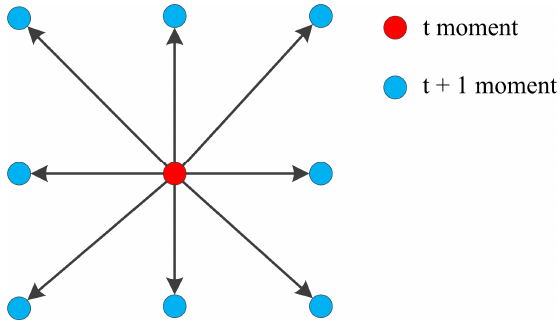
Figure 3. Demonstration of randomly selected path points.